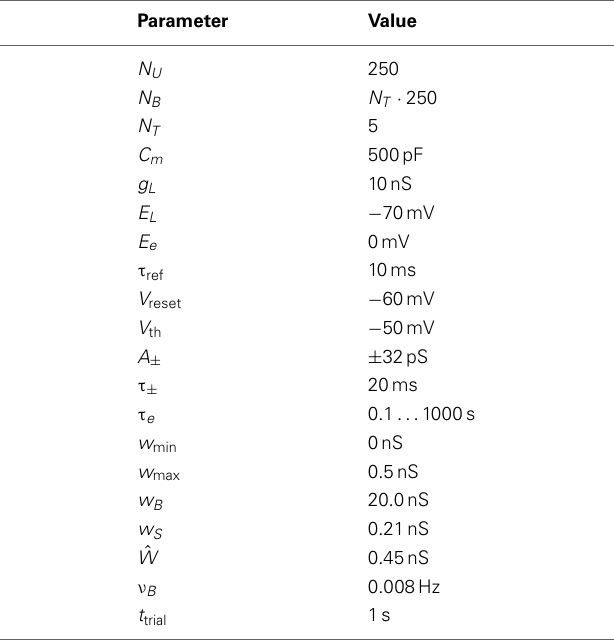
Table 2 | Numerical values for parameters.